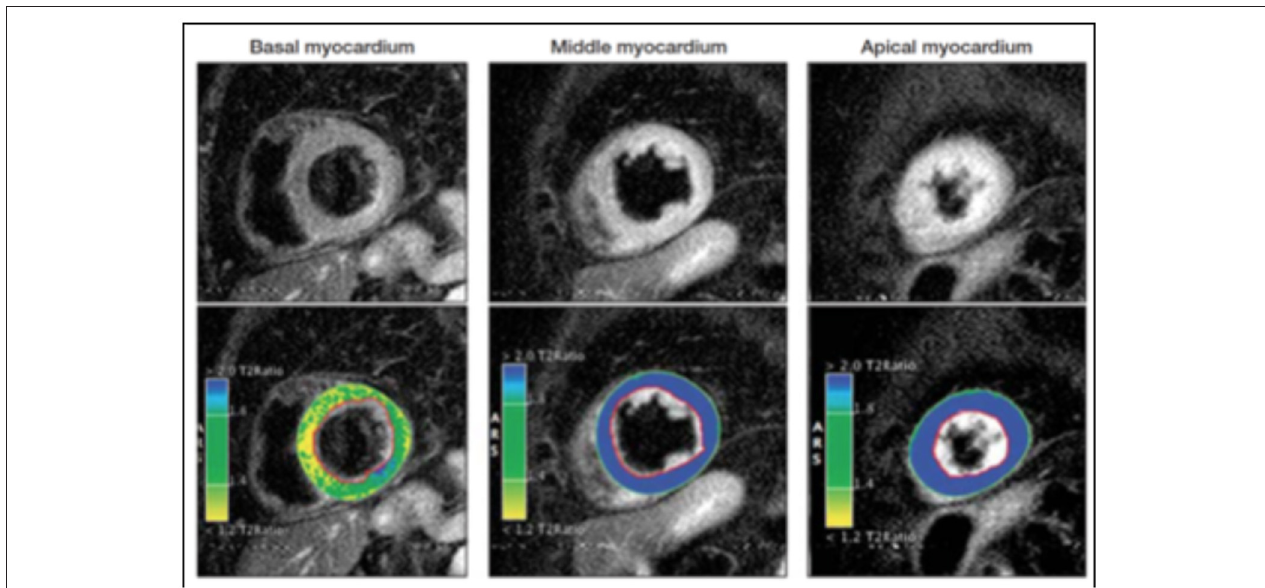
FIGURE 3 | T2-weighted sequences demonstrating variability in signal intensity based on the affected myocardial regions. The color coding resembles varying signal intensity ratios between myocardium and skeletal tissue with blue indicating a ratio ≥ 1.9 (indicating edema) while yellow/green indicates a ratio < 1.9, indicative of normal myocardium. These images illustrate predominant myocardial edema in the mid-ventricular and apical segments. Adapted from Clinical Characteristics and cardiovascular magnetic resonance findings in stress (Takotsubo) cardiomyopathy by Eitel et al. (41).